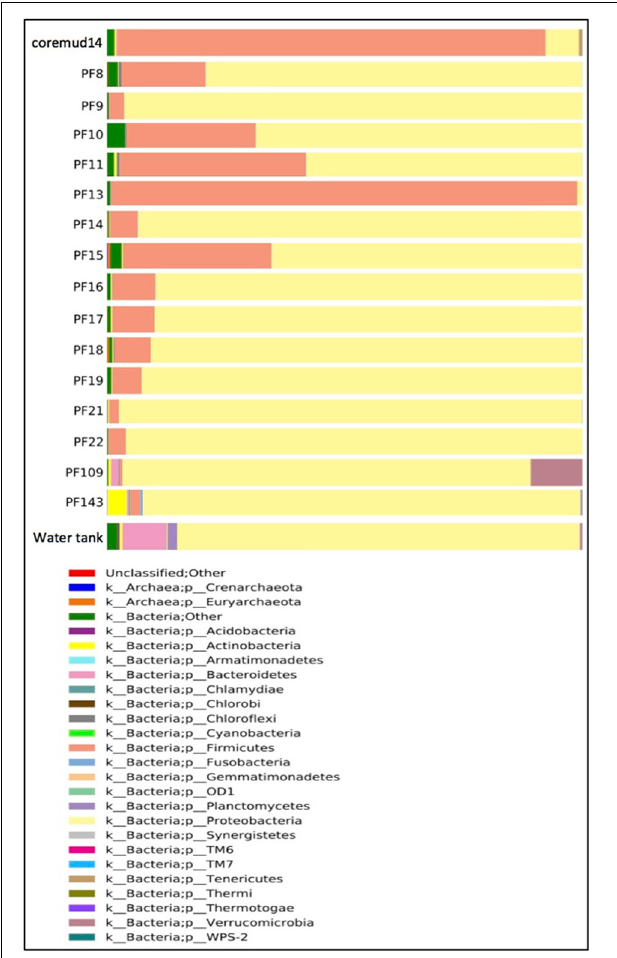
FIGURE 3 | Taxonomical summary of the Paaratte Formation at the phylum level. Taxonomic data from the Ribosomal Database Project were used to classify each representative sequence from drilling mud (coremud14), a subset of pre-scCO 2 and post-scCO 2 injection water samples and a representative aliquot of water from surface storage